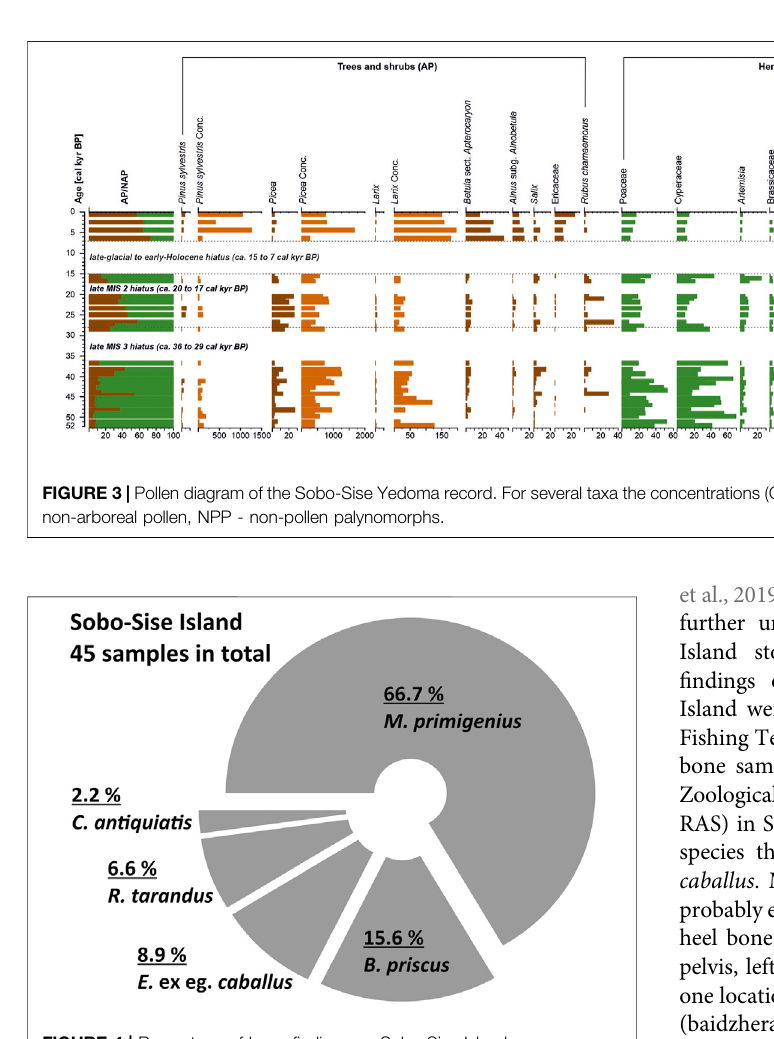
FIGURE 4 | Percentage of bone fi ndings on Sobo-Sise Island comprising archive and new data. Percentages are given above species